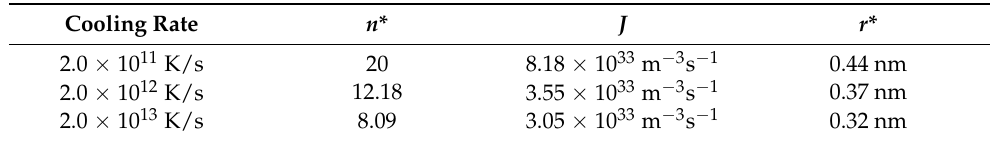
Table 4. Critical size n *, nucleation rate J , and nucleus radius size r * during the isothermal solidifica- tion process with different cooling rates.